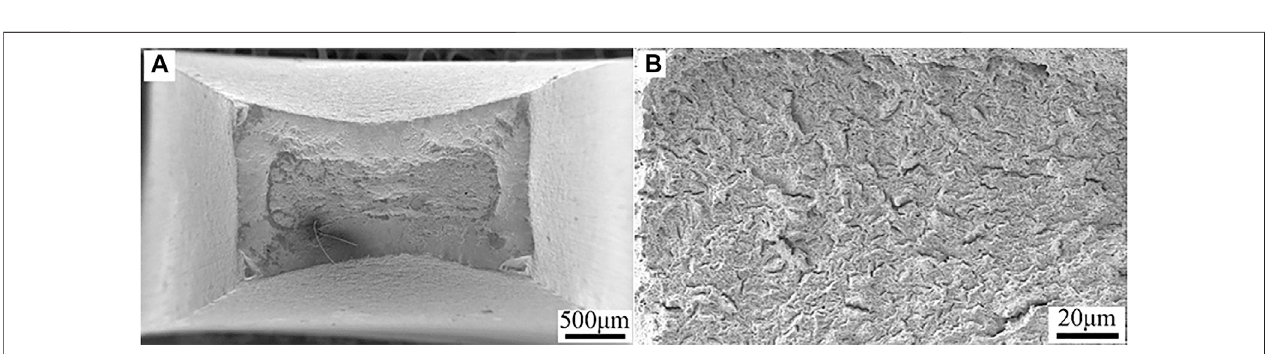
FIGURE 6 | Fracture morphologies of HP-13Cr SS viewed from the top after SSRT at 25 ° C/N 2 atmosphere. (A) low magni fi cation and (B) high magni fi cation.